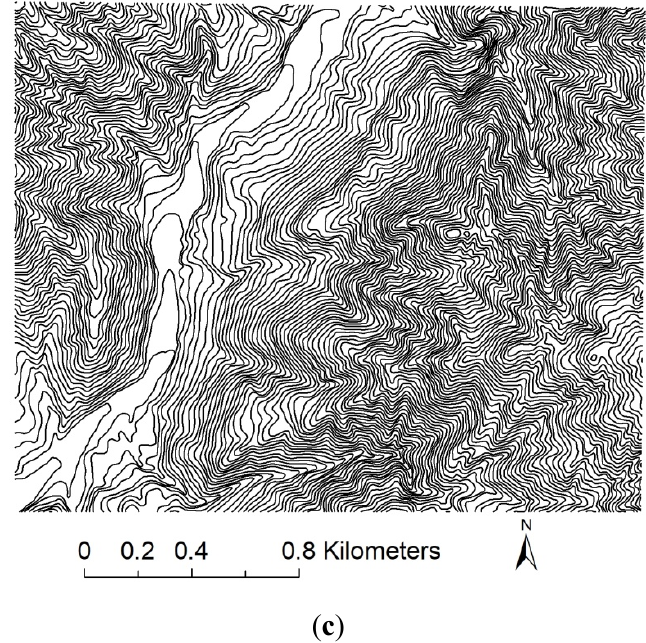
Figure 2. Contour maps of: ( a ) study area 1, ( b ) study area 2, and ( c ) study area 3. The contour interval is 10 m.